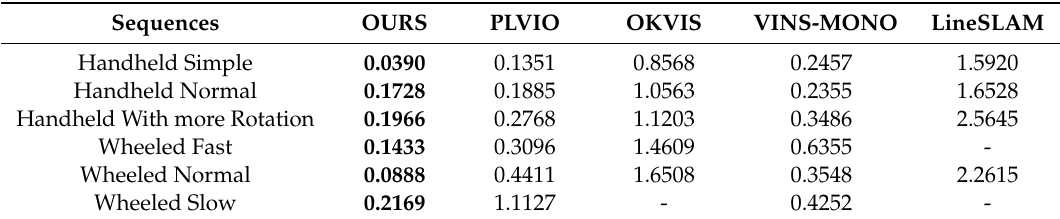
Table 1. The root mean square error (RMSE) of translation on STAR-Center dataset in meters. “-” denotes test